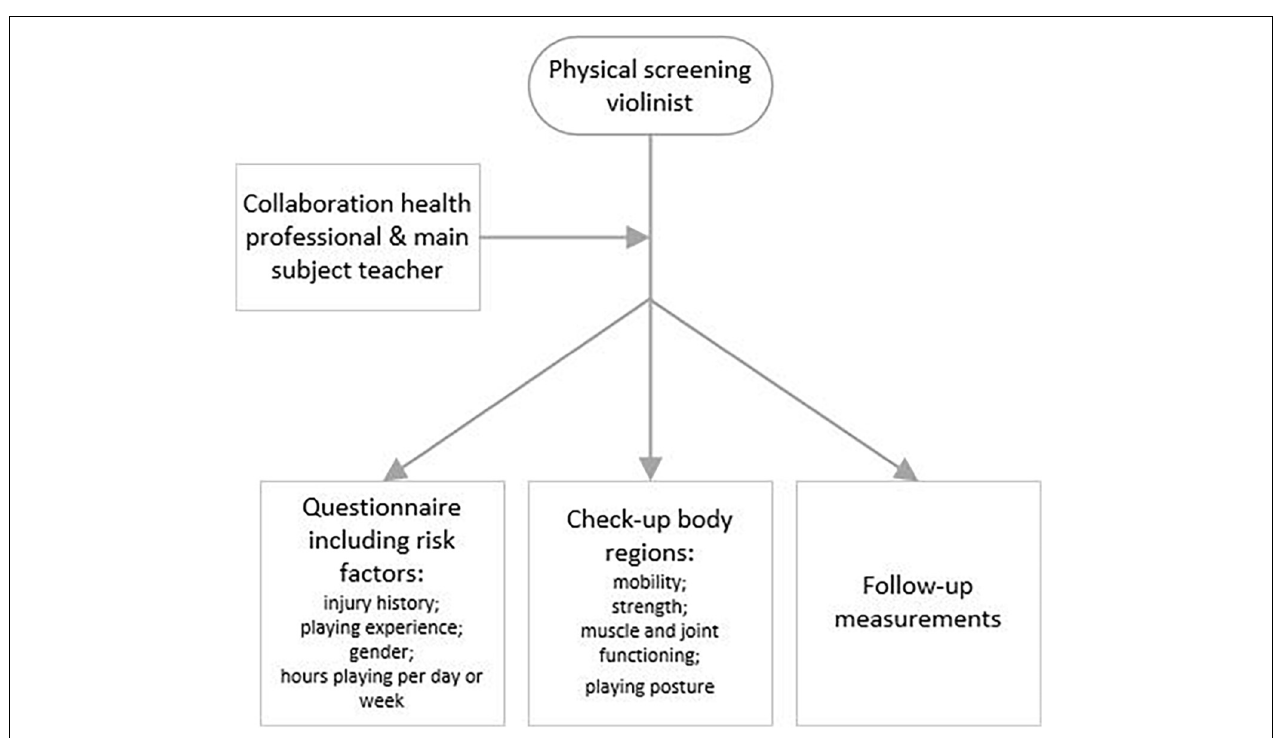
FIGURE 1 | Aspects that should be included in a physical screening tool for violinists according to the